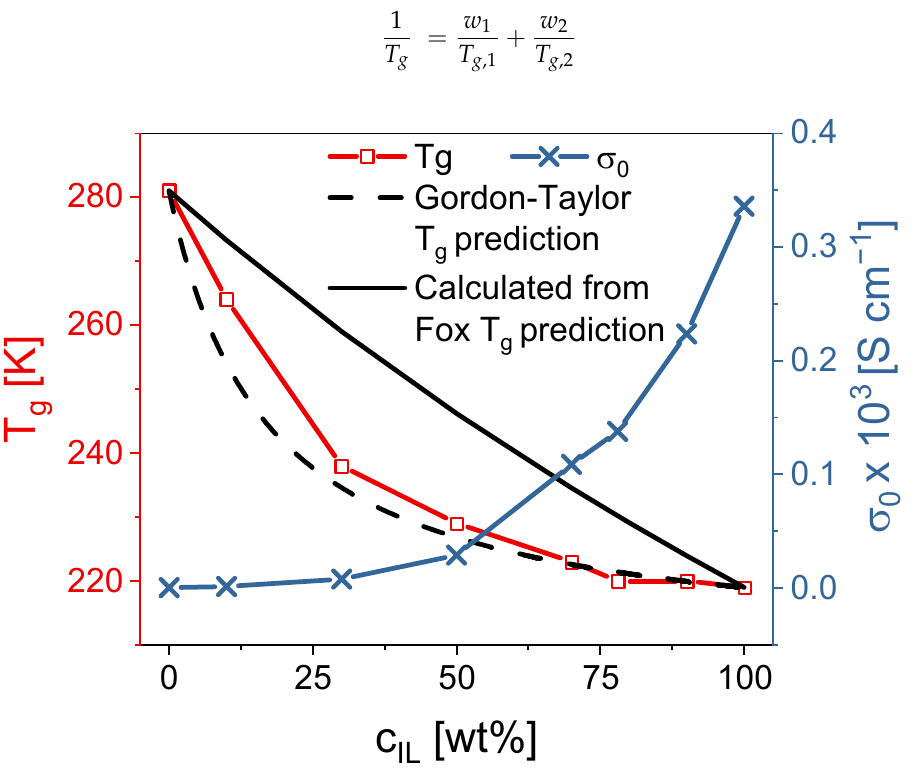
(cid:4667) on the (cid:1846) (left (cid:1877) ‐ axis, red) and ionic con ‐ (cid:3010)(cid:3013) (cid:3034)